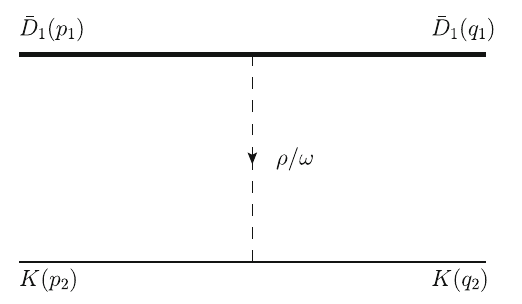
Fig. 1 One-particle exchange diagrams induced by vector mesons ρ and